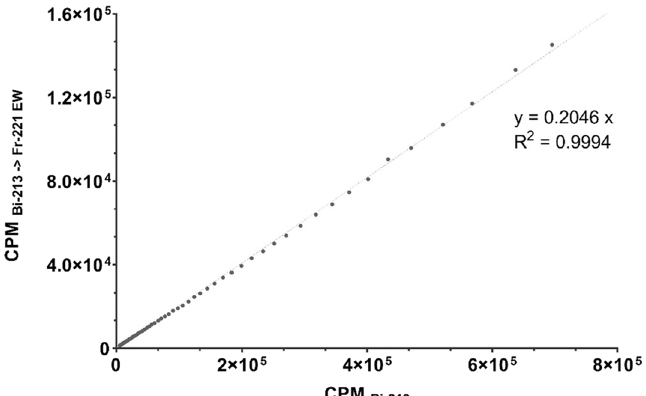
Fig. 4 Count rate of the down scatter of gamma emissions by 213 Bi in the EW 221 different count rates of 213 Bi measured with the EW 213